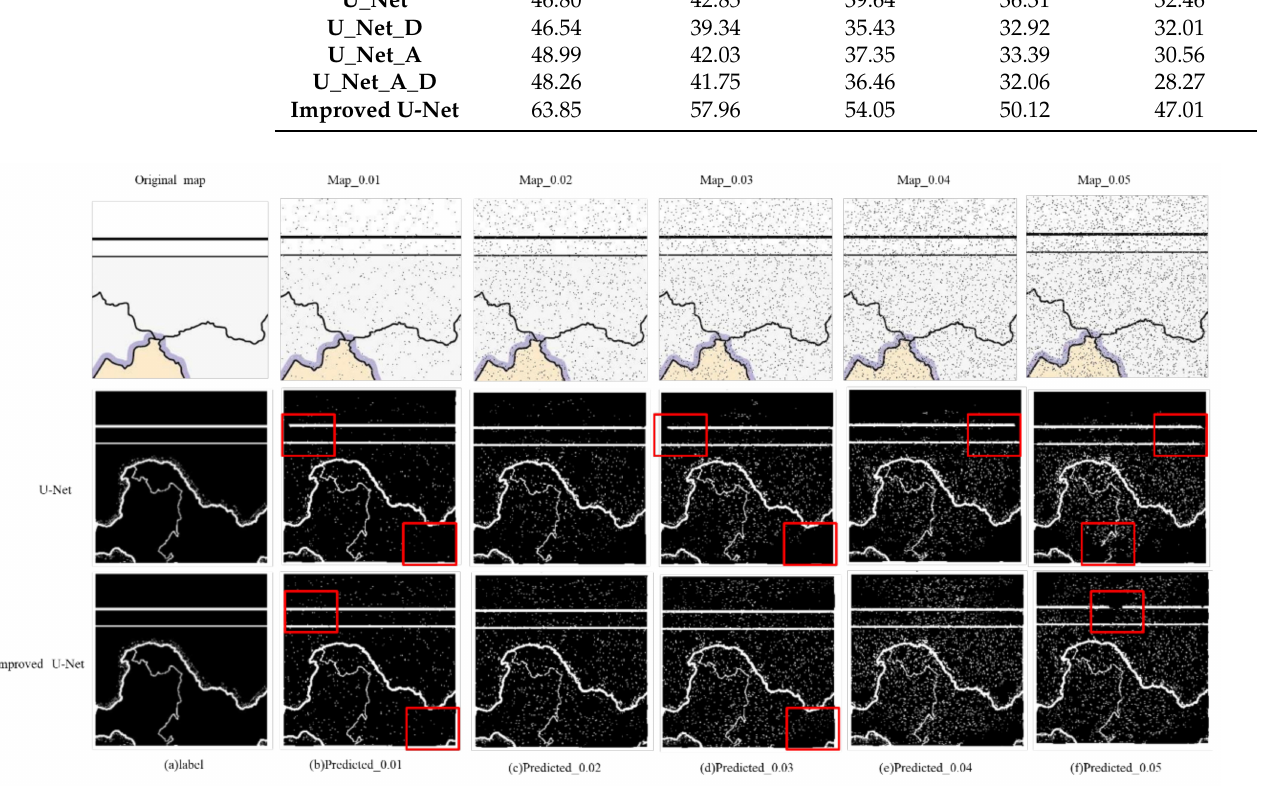
Figure 10. Experimental results with different SNRs: ( a ) map line feature labels, ( b ) the results with SNR of 0.01, ( c ) the results with SNR of 0.02, ( d ) the results with SNR of 0.03, ( e ) the results with SNR of 0.04, and ( f ) the results with SNR of